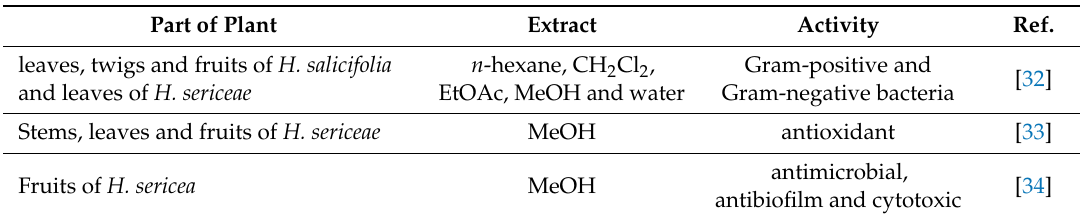
Table 2. Biological activity of extracts of Hakea species.